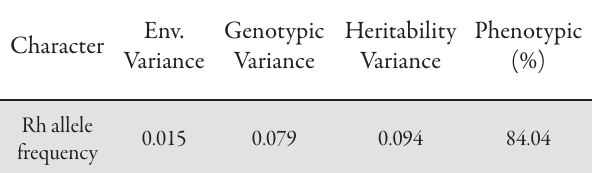
Tab. 3. Genetic parameters of allele frequency of Rh